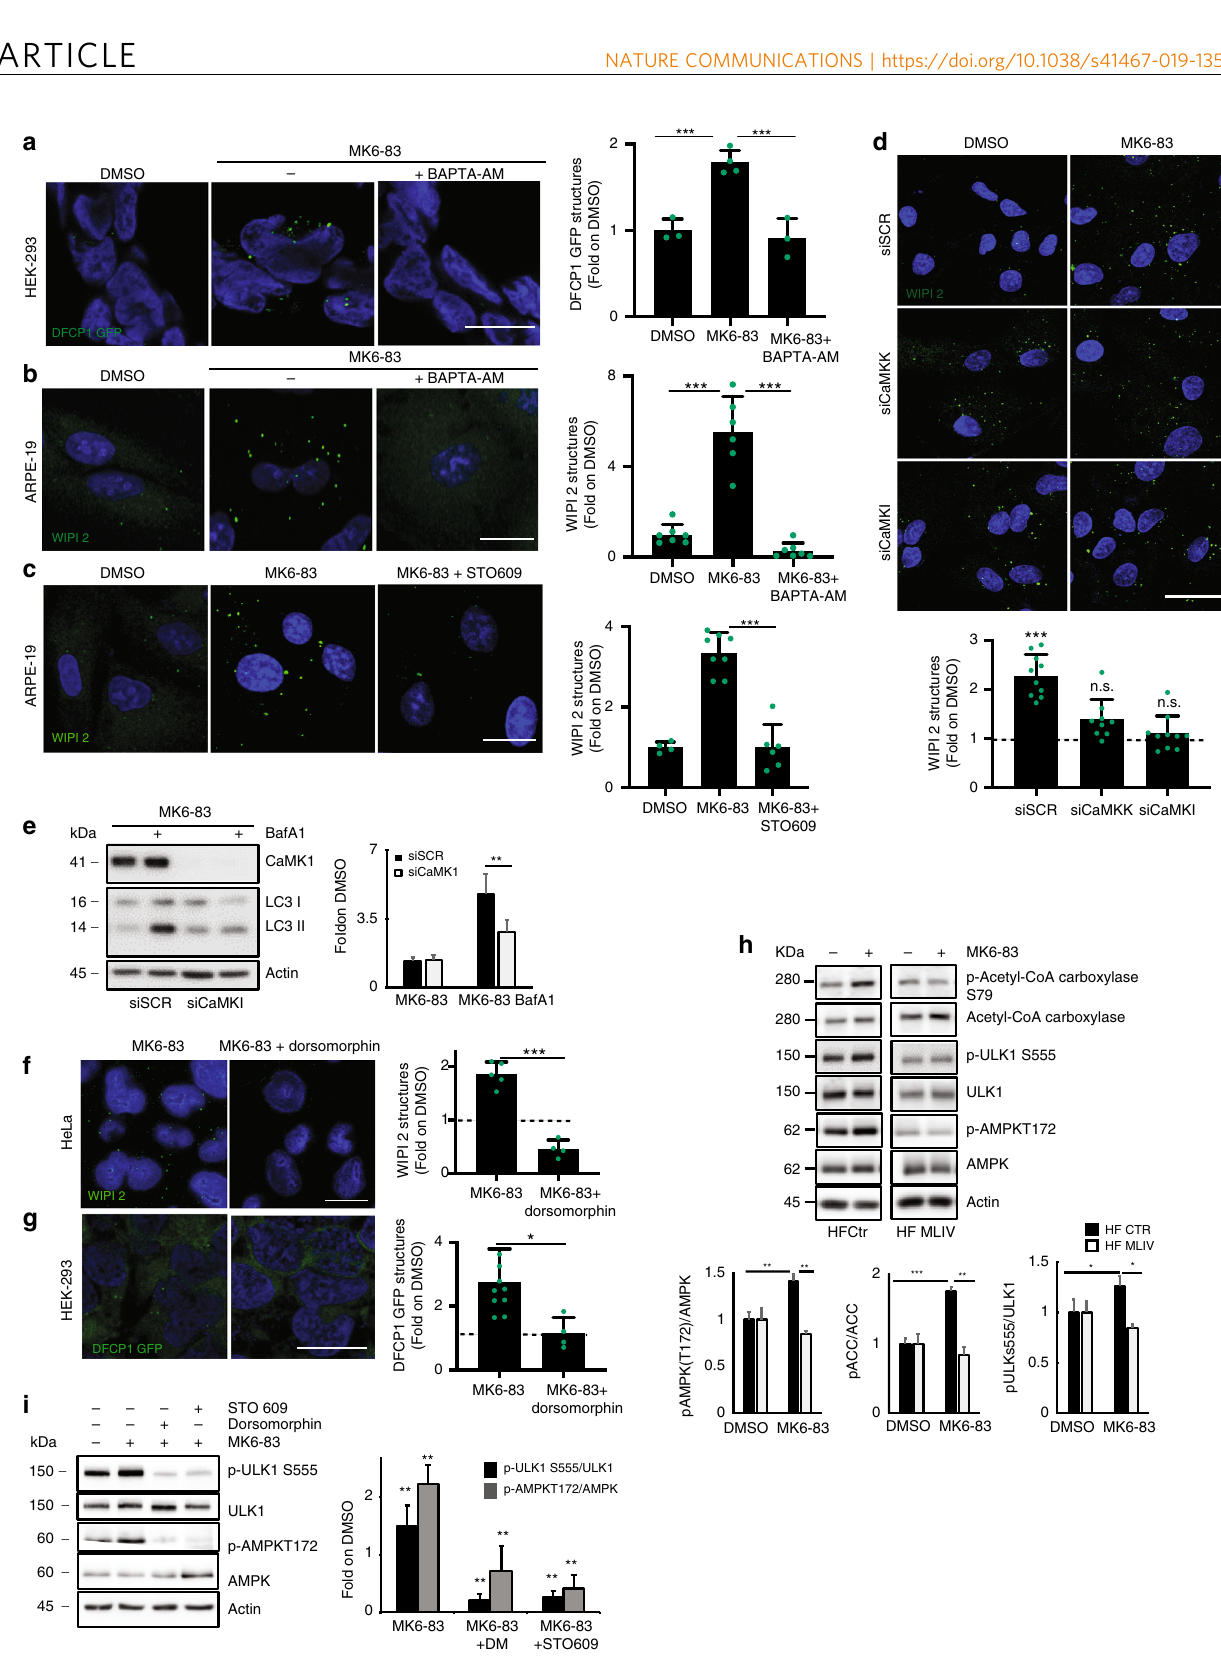
PI3P and an impaired recruitment of essential